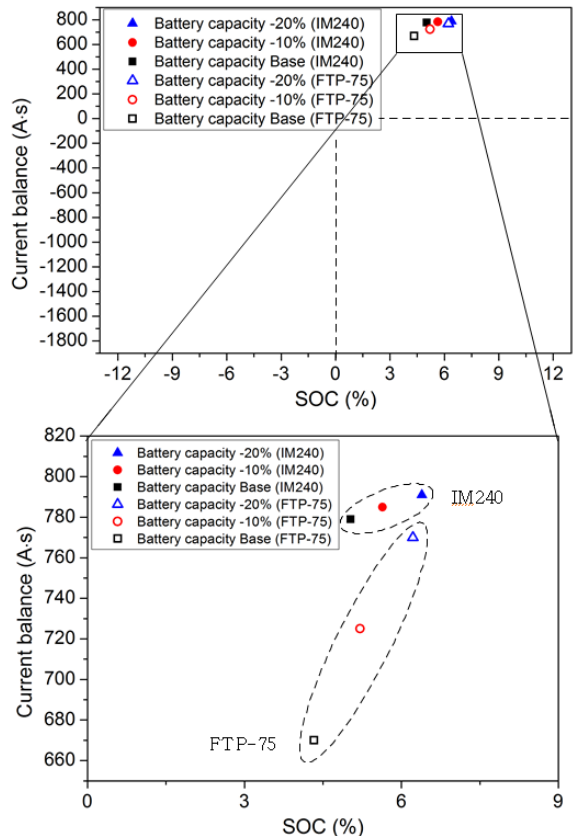
Figure 12. Current balance during IM240 and FTP-75 modes under conditions of reduced battery capacity.